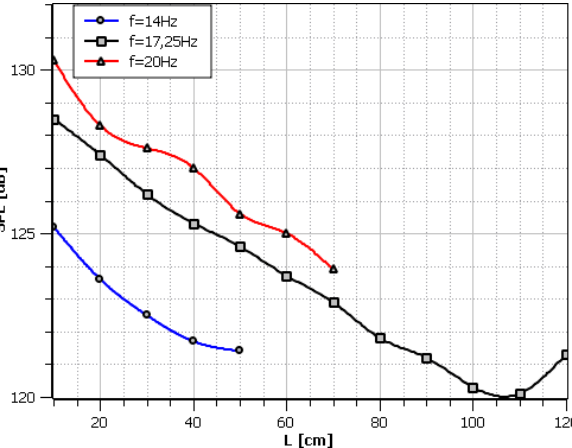
Figure 9: Sound pressure level causing extinguishing effect in the function of the distance from the waveguide output